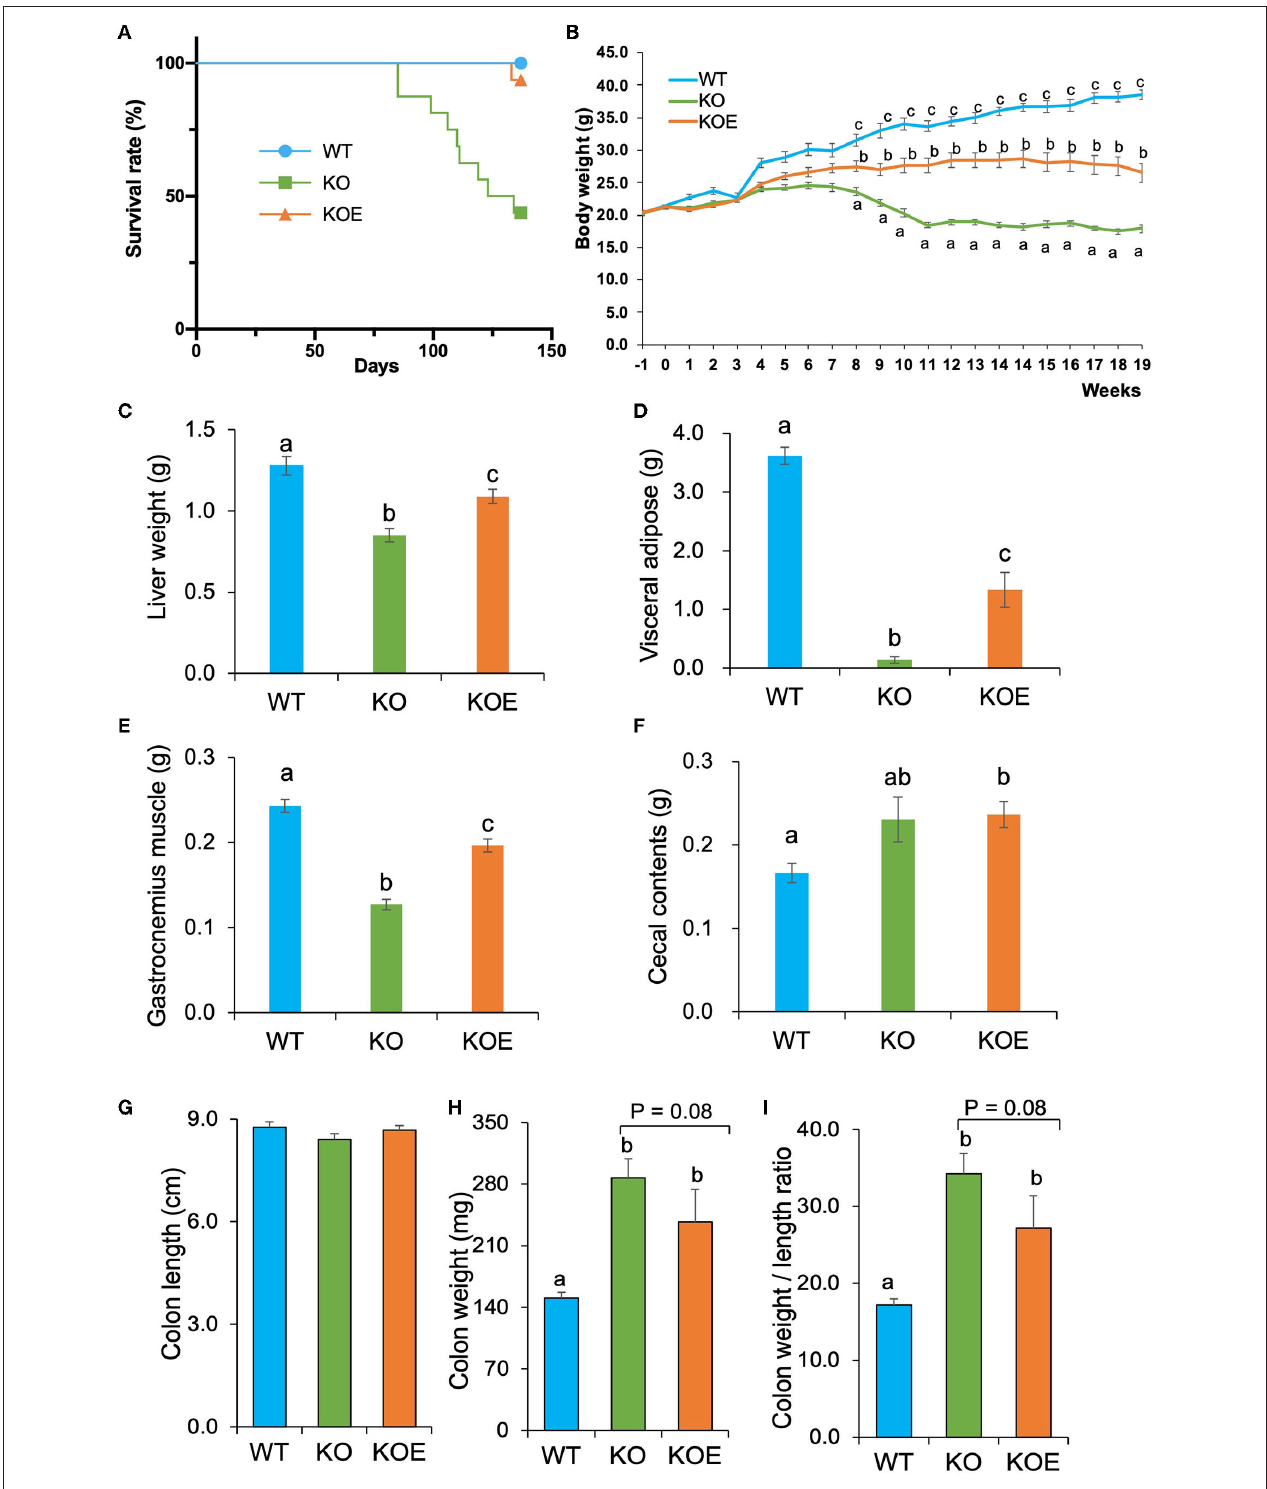
FIGURE 1 | Effect of eggshell membrane (ESM) supplementation on the survival rate and body composition in IL10 − / − mice. (A) Survival rate in wild-type (WT) mice fed with control diet or IL10 − / − mice fed with control diet (KO group) or ESM supplemental diet (KOE group) for 19 weeks. During the treatment period, body weight (B) was measured for each group. After 19-week treatment, liver weight (C) , visceral fat pad weight (D) , gastrocnemius muscle weight (E) , cecal content weight (F) , colon length (G) , colon weight (H) , and colon weight to length ratio (I) were calculated (WT: n = 8, KO and KOE: n = 7, respectively). Data are presented as mean ± standard error. Superscript with different letters indicate significant difference at P <